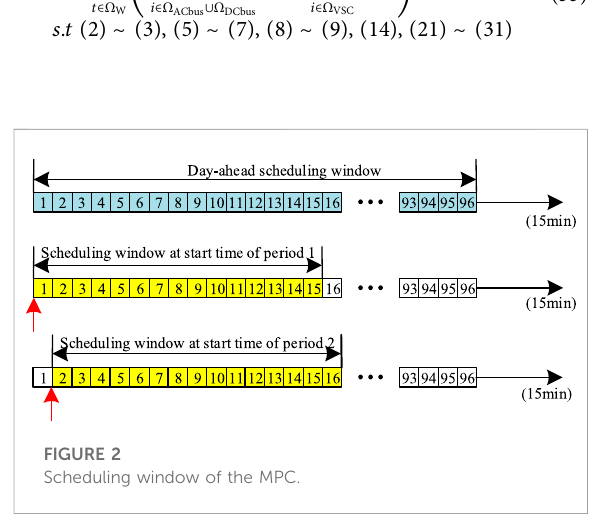
FIGURE 2 Scheduling window of the